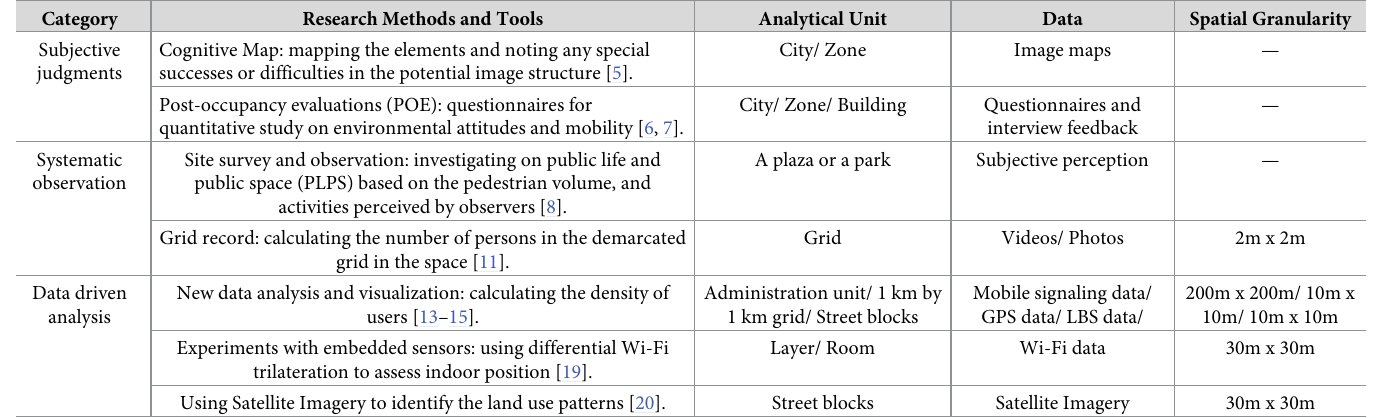
Table 1. Classification of methods for measuring the usage of public space.